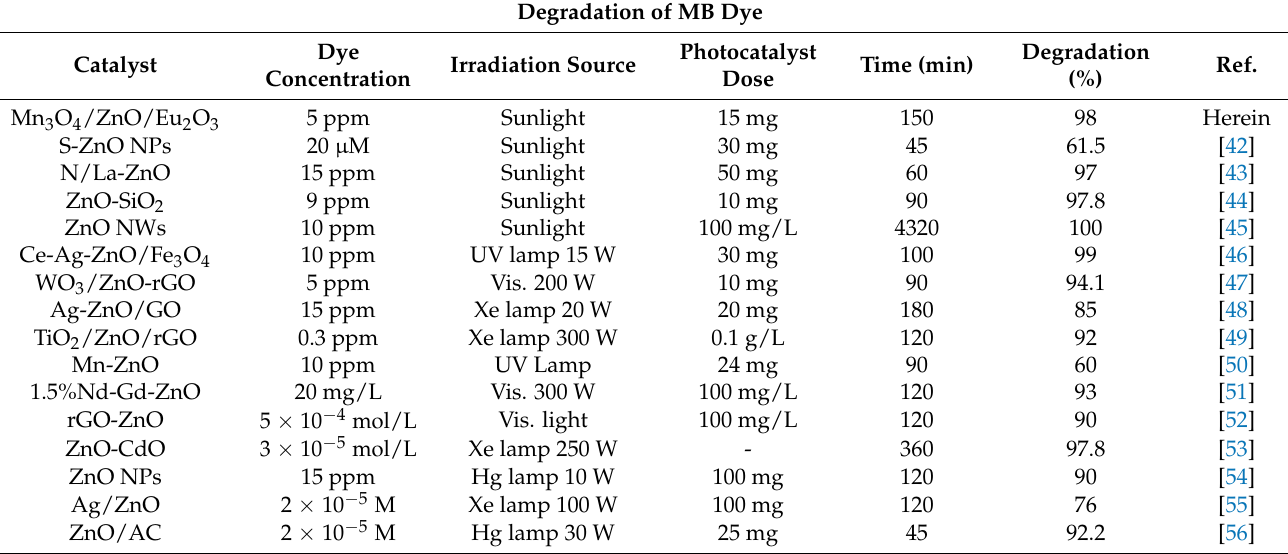
Table 1. Comparative studies of Mn 3 O 4 /ZnO/Eu 2 O 3 for degradation of MB and MO dyes with several formerly reported analogous